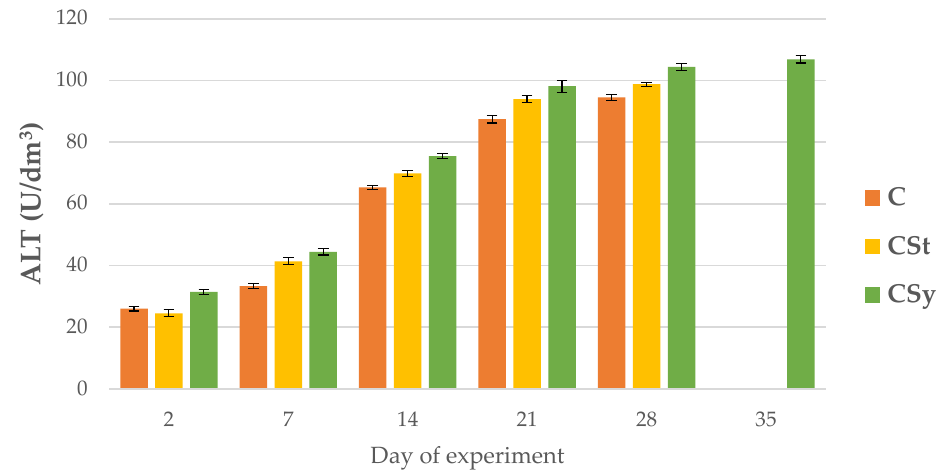
Figure 10. ALT activities in the 2, 7, 14, 21, 28, 35-day-old honey bees’ hemolymph after two methods of supplementation with hemp extract: C-control (pure sugar syrup), CSy-hemp extract in syrup, CSt-hemp extract on strips. Two-Way ANOVA: supplementation method: F (2, 156) = 4.3070, p = 0.01511, se ± 3.750347 – 4.150009; days of supplementation: F (4, 143) = 26349, p = 0.0000, se ± 0.19505 – 0.337837; supplementation method × days of supplementation F (8, 143) = 30.235, p = 0.0000, se ± 0.337837.